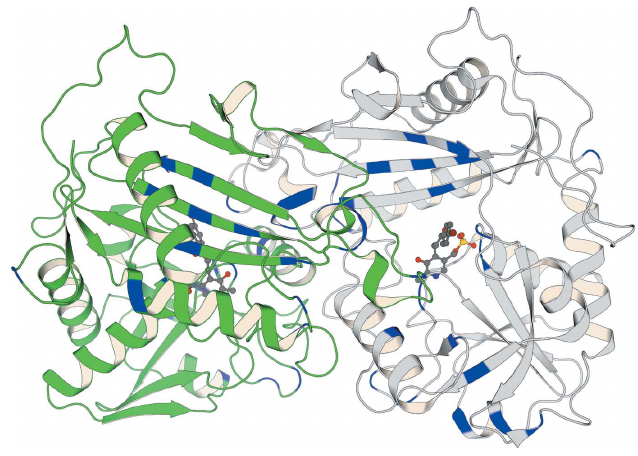
Figure 1 A prominent example of semi-rational directed evolution of an ( R )- selective amine transaminase for sitagliptin manufacture (Savile et al. , 2010). Shown here is the structure of the final variant after 11 rounds of evolution (PDB entry 5fr9; Cuetos et al. , 2016). Achieving this industrially applicable enzyme required 27 amino-acid substitutions, the positions of which are highlighted here in blue in both chains of the structure. This figure illustrates how diversely distributed across an enzyme functionally important residues can be, and therefore why it can be so hard to predict appropriate amino-acid substitutions using only rational design approaches. Chain A is coloured light grey and chain B green, and the covalent cofactor–inhibitor complex of both subunits is shown in dark grey using a ball-and-stick representation for better clarity. This and all figures showing crystal structures were created using the PyMOL Molecular Graphics System (Version 1.8, Schro¨dinger